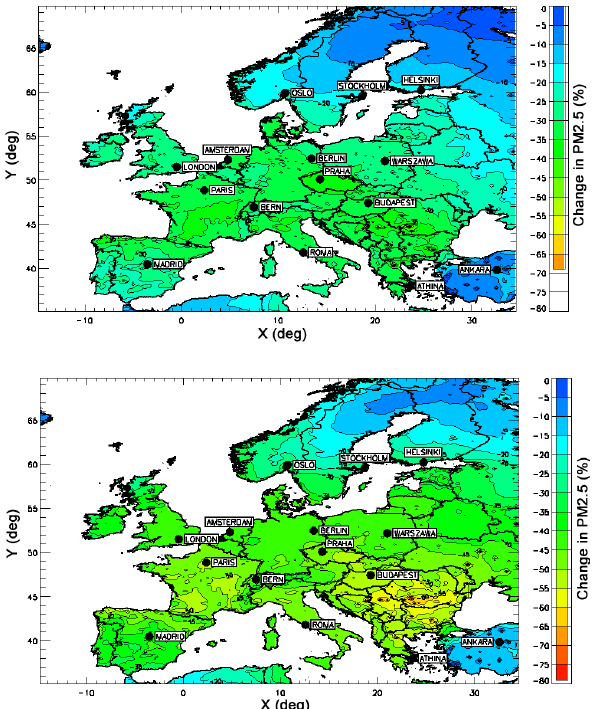
Figure 6. Relative changes in annual average PM 2 . 5 concentrations over the European domain for two scenarios: BL 2020–2005 (upper panel) and MTFR 2020–2005 (lower panel).